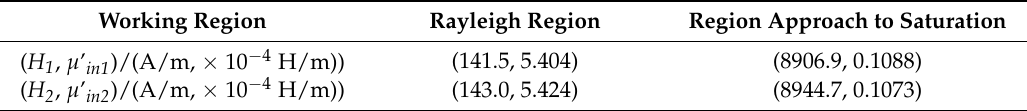
Table 2. The extrapolated points for Rayleigh region and the region approach to saturation. Working